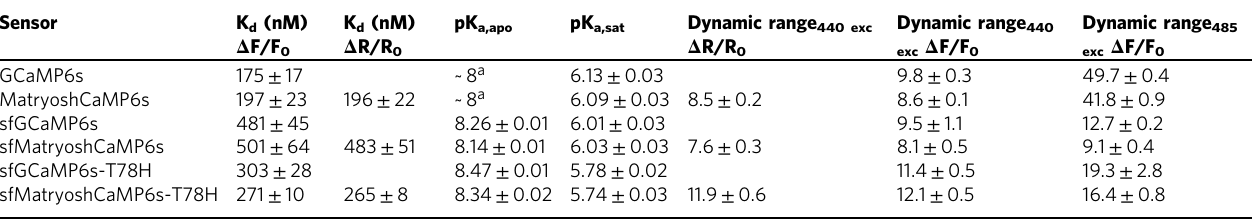
Table 1 In vitro properties of puri fi ed GCaMP6 and MatryoshCaMP6s calcium sensors